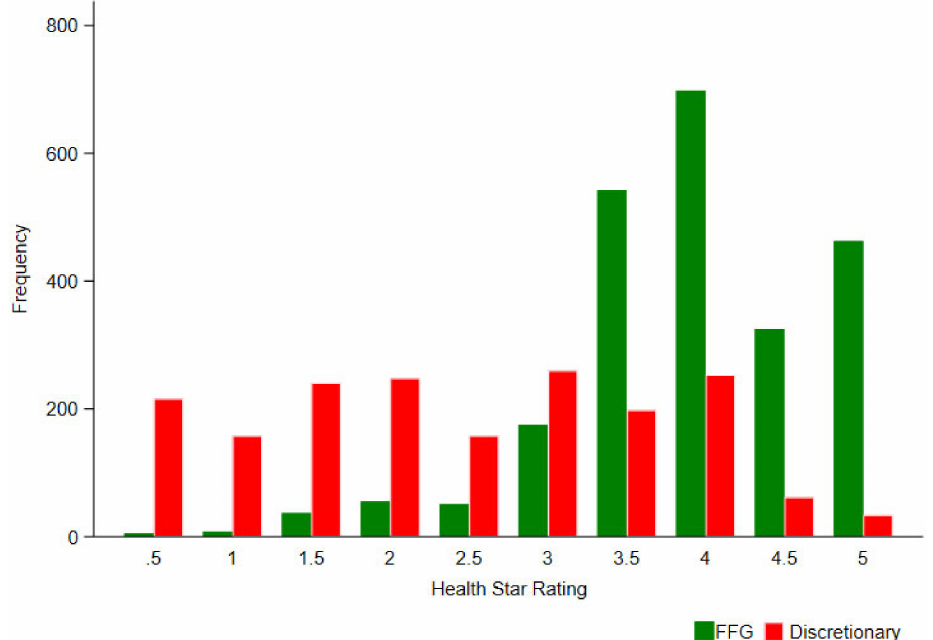
Figure 4. Health Star Rating frequency for the total sample: Five food group (FFG) foods compared to discretionary foods.